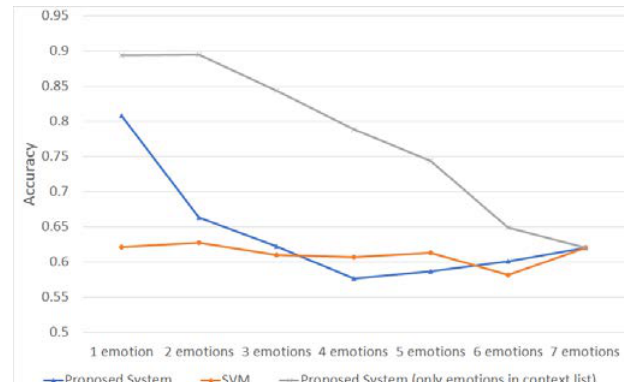
Figure 12. Performance comparison – adding emotions step by step in the context information